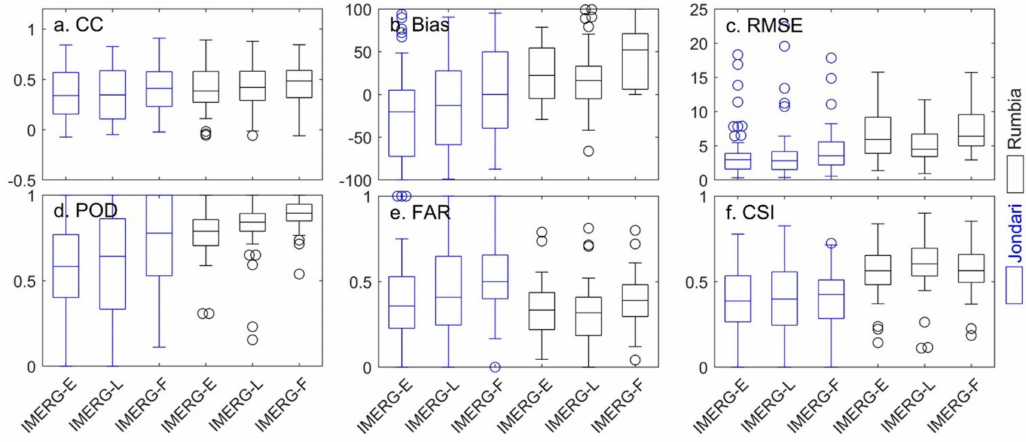
Figure 4. Temporal distribution of hourly frequency accumulation for: ( a , d ) light rain (0.1 ≤ R < 2.5 mm) ( b , e ) moderate rain (2.5 ≤ R < 8 mm), and ( c , f ) heavy rain (R ≥ 8 mm) over YRD.